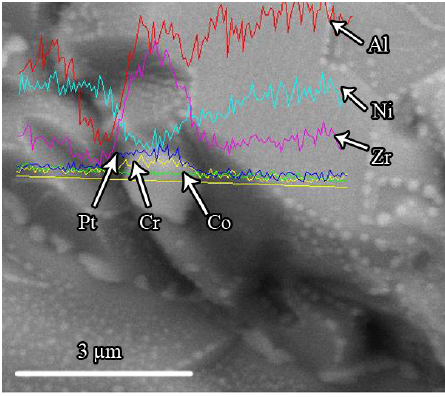
Figure 5. The line scanning image of precipitated phase formed on the surface of the PtZrAl coating.